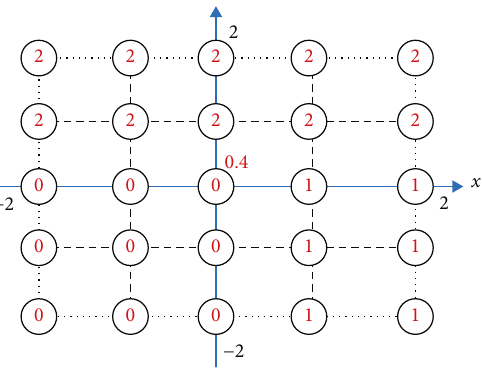
Figure 3: First generation of f